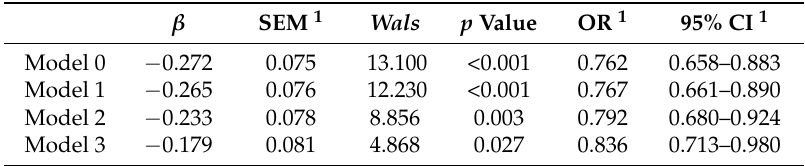
Table 4. Association between vitamin D intake and vitamin D